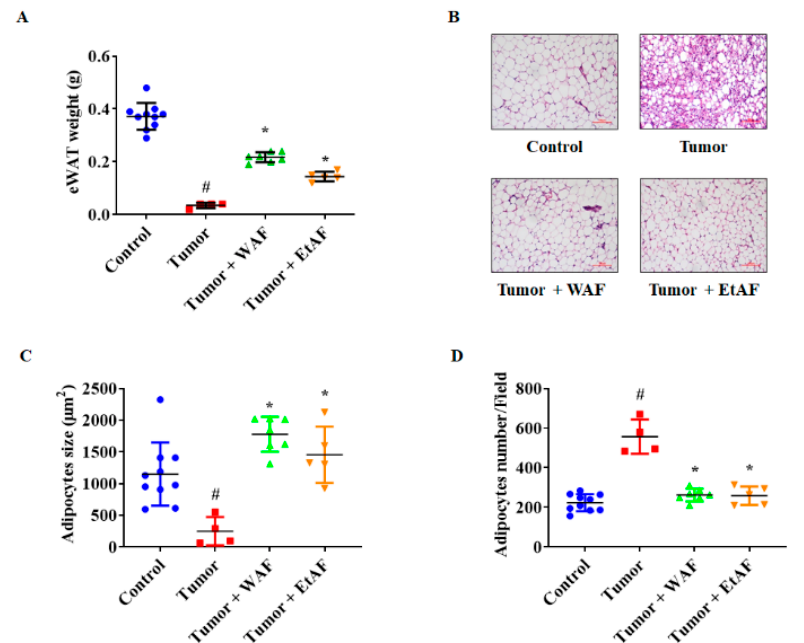
Figure 6. E ff ects of AF on eWAT wasting in intraperitoneally CT-26 tumor-bearing mice. The weight of eWAT was measured after sacrificing mice ( A ). The H&E staining images of eWAT ( B ). The magnitude is × 200 and the scale bar is 100 µ m. Adipocyte size was measured using ImageJ ( C ). The adipocyte number of each group was counted by randomly selecting fields ( D ). All values are mean ± SD. # p < 0.05, significantly di ff erent from control group; * p < 0.05, significantly di ff erent from tumor group.